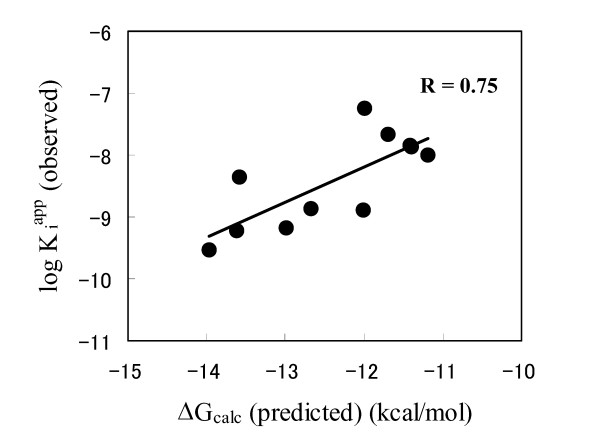
Plot of the least squares fit plot of the predicted binding free energies (ΔGcalc) (kcal/mol) vs experimentally observed Kiapp values. Least squares fit analysis performed over set of the data points in Table 2 yielded the following equation, log Kiapp = +0.56ΔGcalc - 1.43.